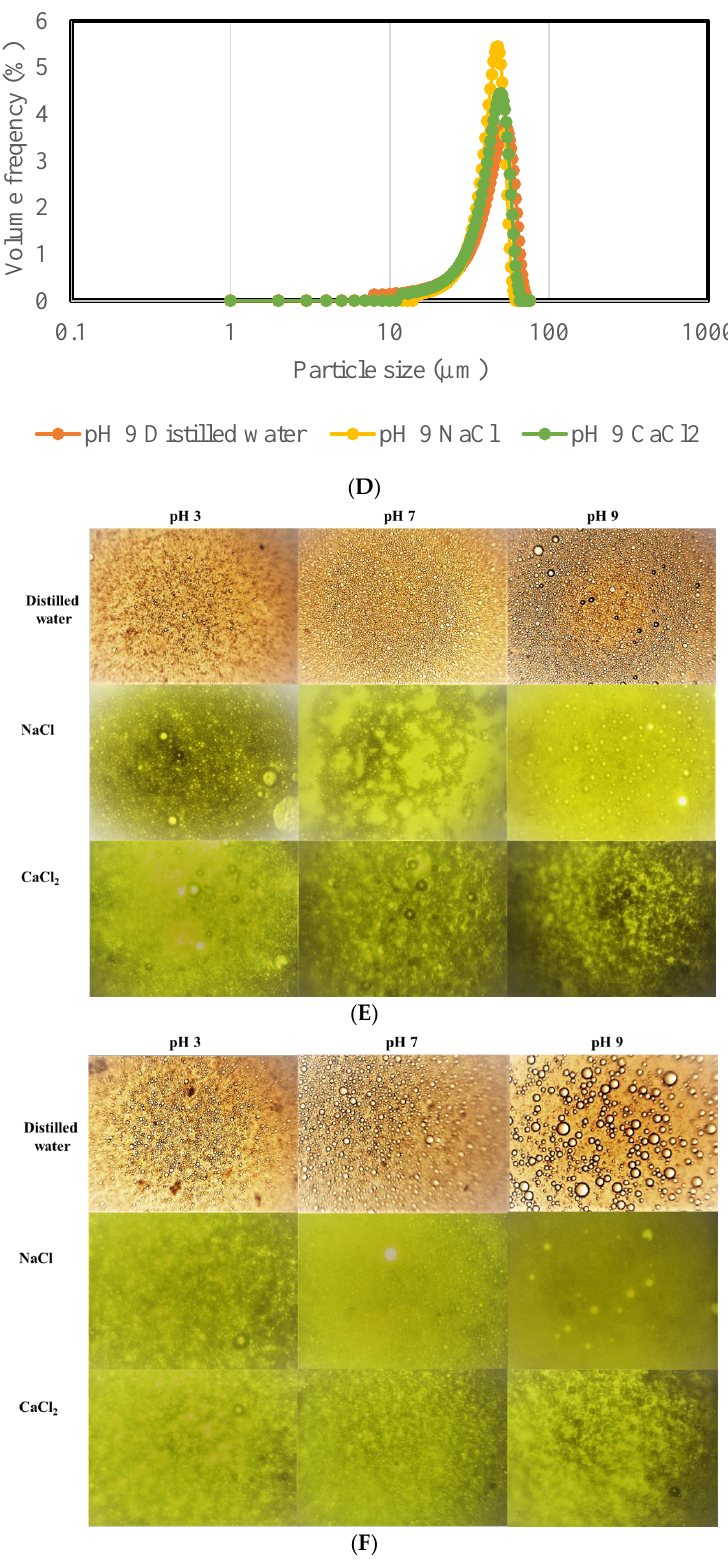
Figure 3. Droplet sizes of API emulsion ( A ) at different pH mediums in distilled water and in the presence of NaCl and CaCl 2 , emulsion particle size distribution ( B – D ), emulsion photograph at zero time ( E ) and after 2 h storage ( F ). Different letters (a–c) represent significant differences among data. The significant difference was calculated individually among each